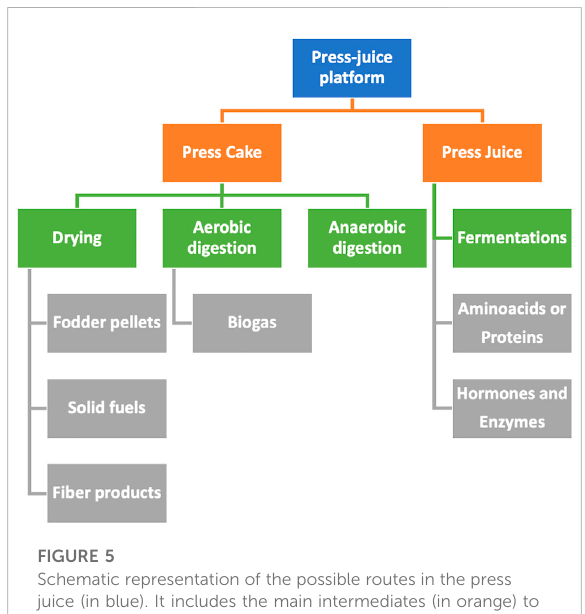
FIGURE 5 Schematic representation of the possible routes in the press juice (in blue). It includes the main intermediates (in orange) to produce valuable products (in gray), through different processes (in